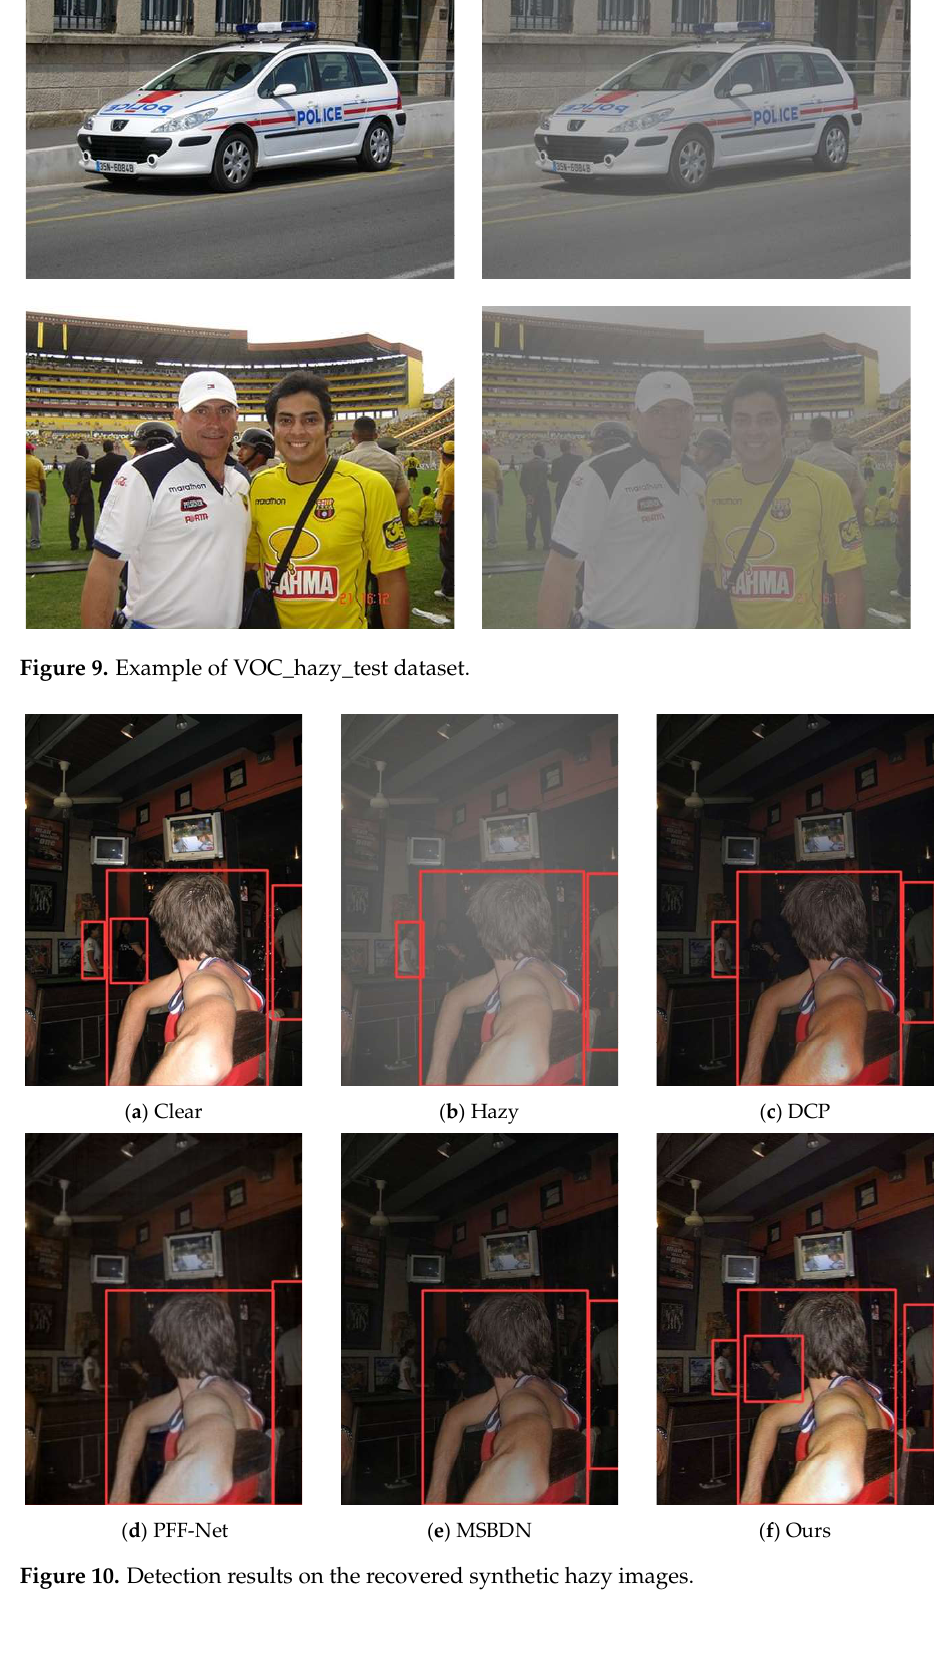
Figure 10. Detection results on the recovered synthetic hazy